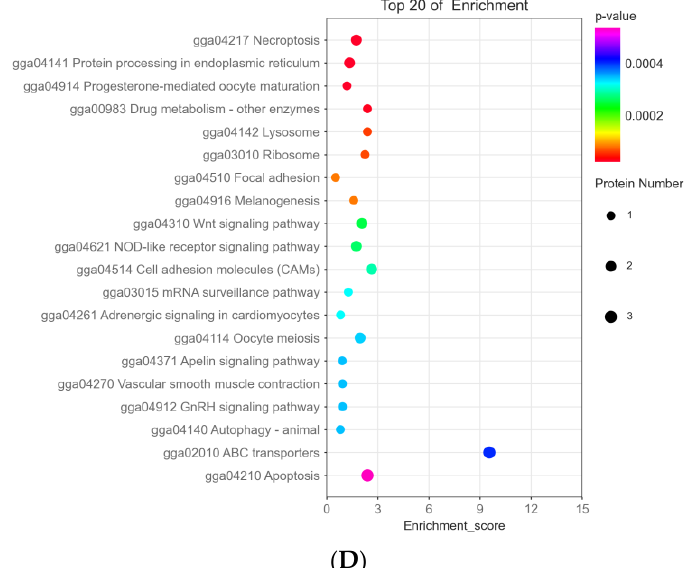
Figure 4. The results of functional enrichment analysis of DPPs. ( A ) Enriched GO-BP terms for up-regulated DPPs. ( B ) Enriched GO-BP terms for down-regulated DPPs. The x − axis is the − log10 P adj and the y − axis is the GO-BP terms in ( A , B ). ( C ) Enriched KEGG pathway for up-regulated DPPs. ( D ) Enriched KEGG pathway for down-regulated DPPs. The x − axis is the fold enrichment, and the y − axis is the KEGG pathways. The bubble size indicates the number of DPPs, and the color indicates the p value in ( C , D ).